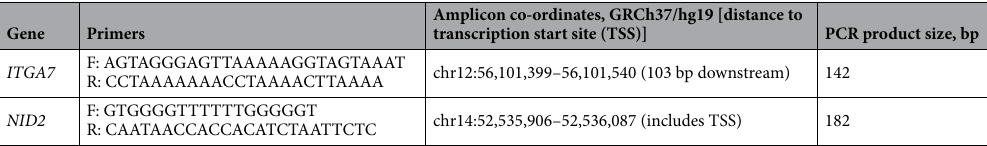
at http://mapla b.imppc .org/wande rer.